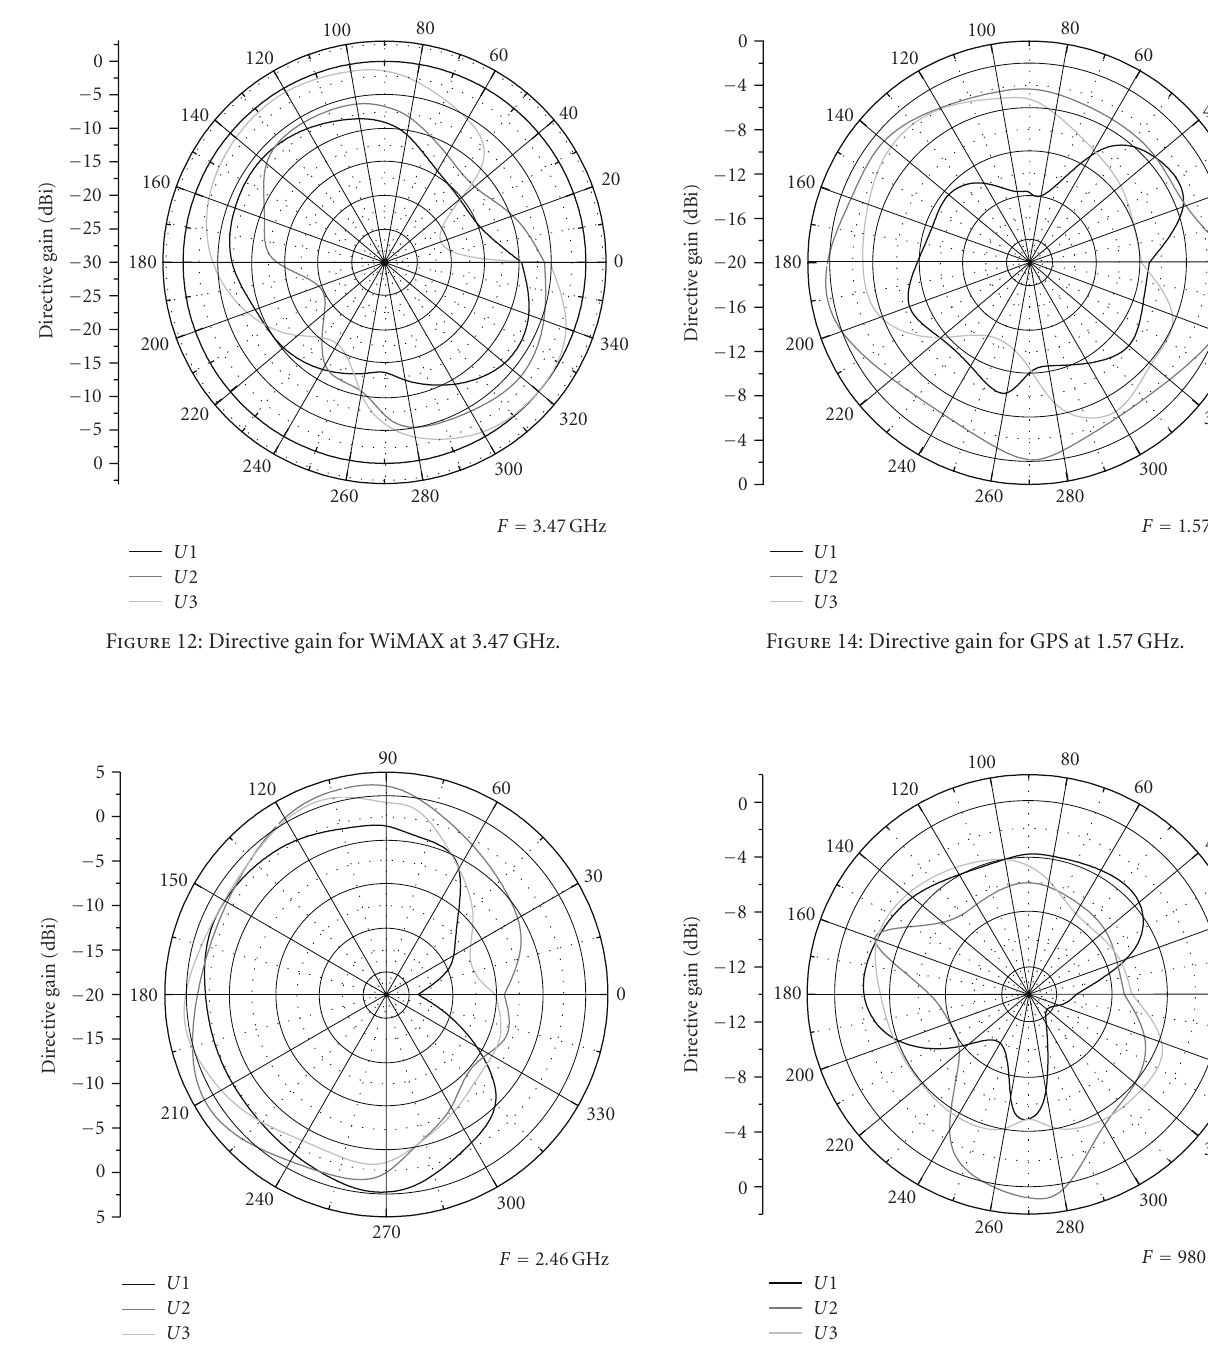
Figure 15: Directive gain for GSM at 980MHz.